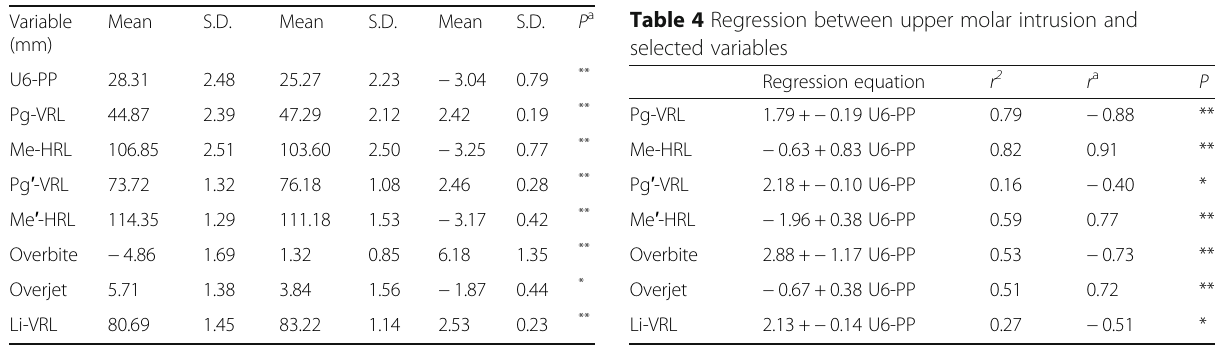
Table 2 Comparison of selected variables before and after maxillary posterior teeth intrusion Before intrusion